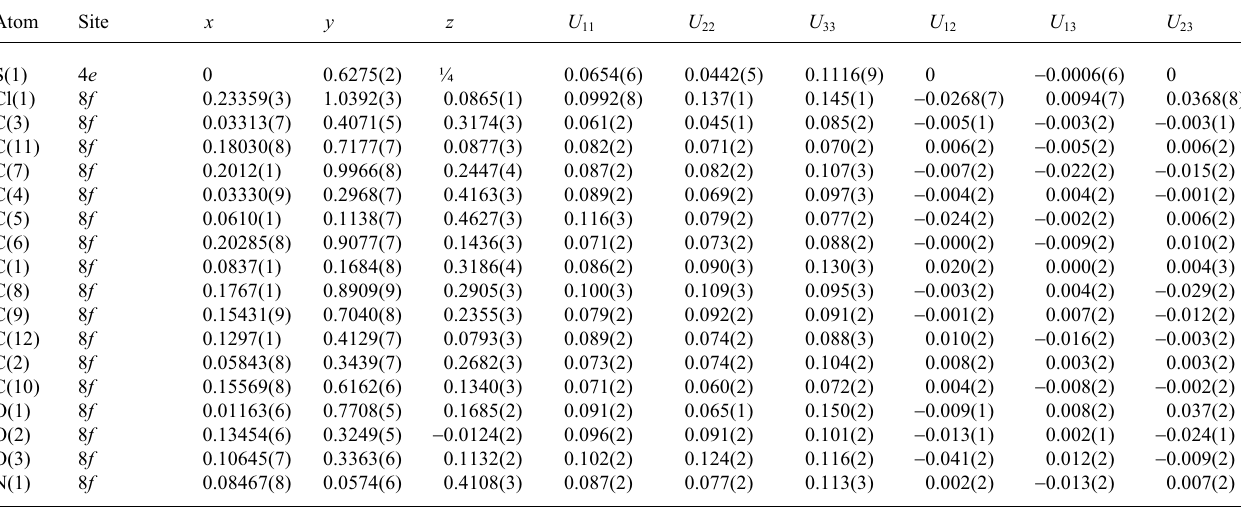
Table 3. Atomic coordinates and displacement parameters (in Å 2 )